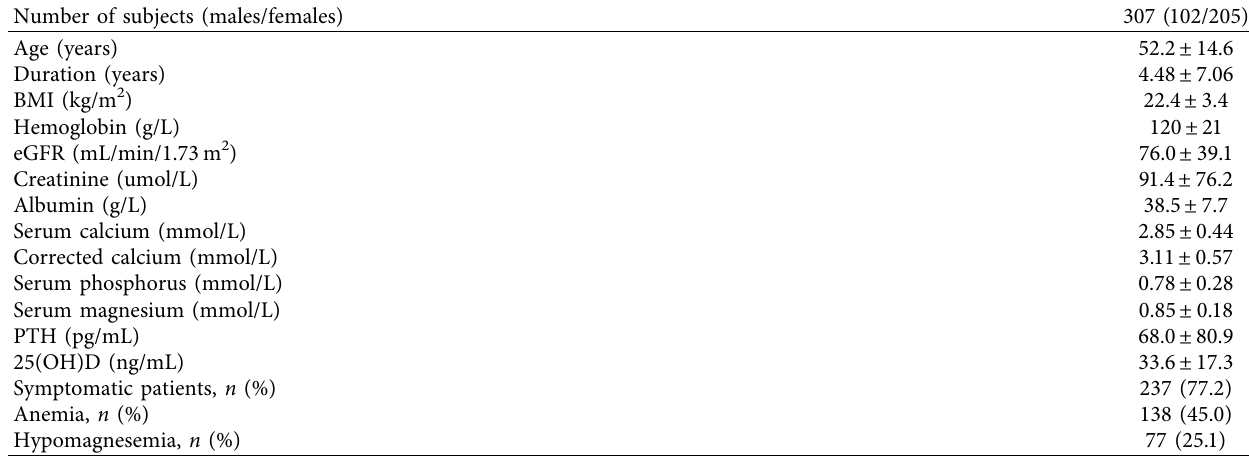
Table 1: Baseline characteristics of the subjects.